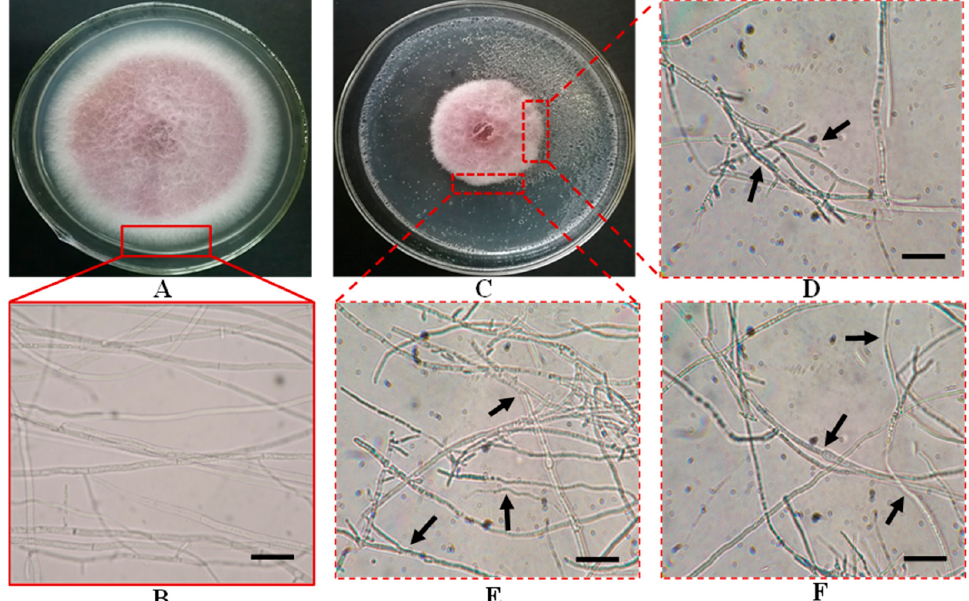
Figure 4. In vitro inhibition of mycelial growth of F. oxysporum in co‑culture with P. caperatum MR‑16 on PDA medium. ( A , B ): F. oxysporum in single culture. ( C – F ): Mycelia of F. oxysporum in co‑culture with culture filtrate of MR‑16. Scale bars = 20 µm.